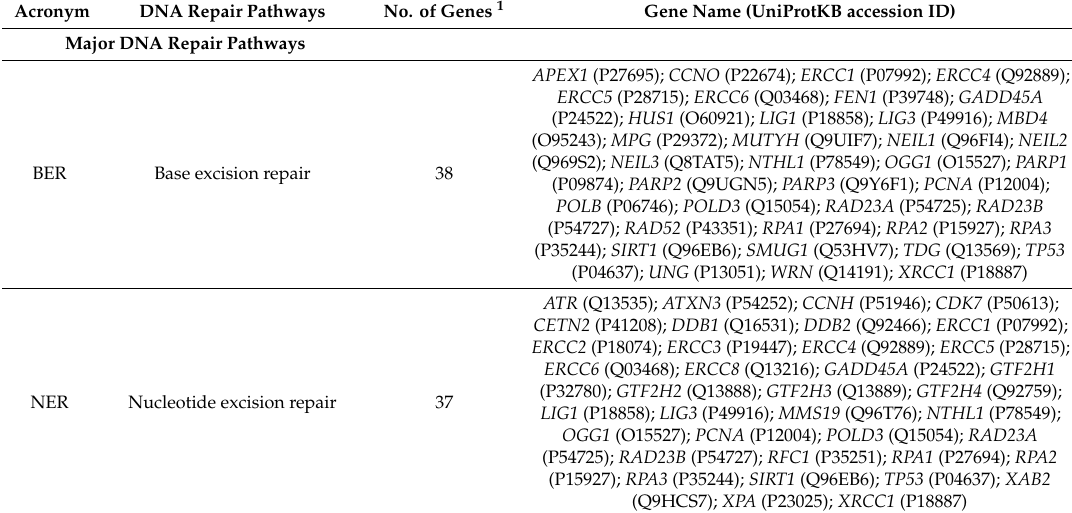
Table 1. DNA repair genes and their associated DNA repair-related pathways investigated in this